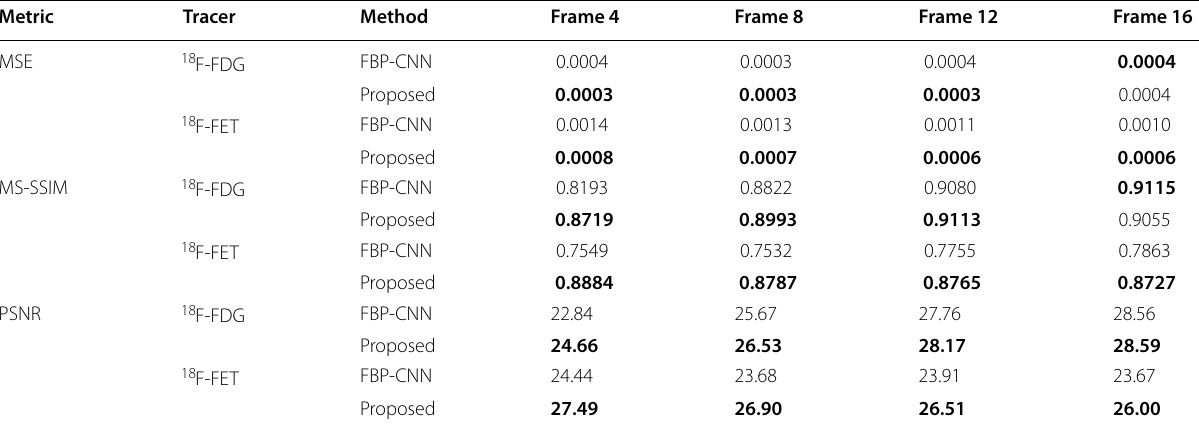
Table 3 Quantitative results of the animal experiment